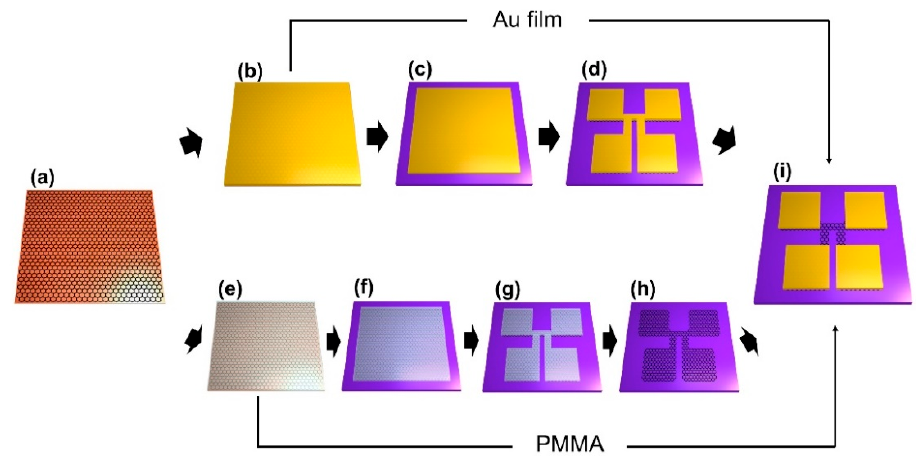
Figure 1. Schematic of graphene FET fabrication. ( a ) Growth of graphene on Cu film, ( b ) Thermal evaporation of Au (30 nm) on the graphene/Cu, ( c ) Transfer of Au/graphene on SiO 2 /Si substrate after chemical etching of underlying Cu film, ( d ) Photolithographic patterning of the Au/graphene with 4-terminal Hall-bar structure, ( e ) PMMA coating on the graphene/Cu, ( f ) Transfer of PMMA/graphene after Cu etching and subsequent PMMA removal ( g ) Photolithographic patterning of the graphene with 4-terminal Hall-bar structure, ( h ) Etching of the unpatterned graphene by O 2 RIE, and ( i ) Fabrication of GFET with exposed graphene channel. For graphene transferred by Au assisted method, the Au layer on the channel was selectively etched. For graphene transferred by PMMA assisted method, Cr/Au (5/30 nm) were deposited on the electrode area.